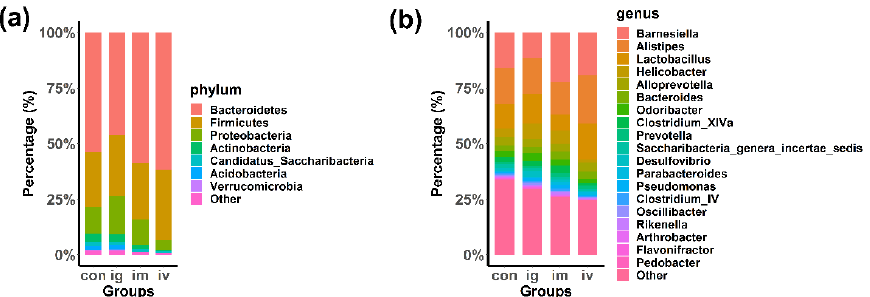
Figure 4. Predominant bacteria identified in the intestinal tissues of mice. ( a ) Intestinal microflora dispersion at the phylum level; ( b ) intestinal microflora dispersion at the genus level.